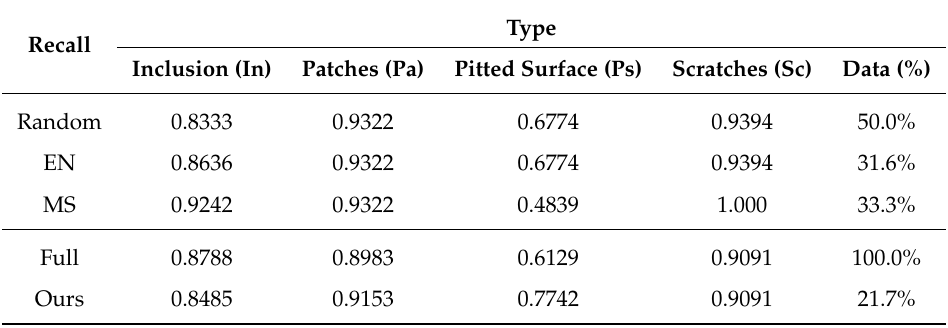
Table 1. Comparison of Recall on the NEU-DET dataset. The best results are shown in boldface.